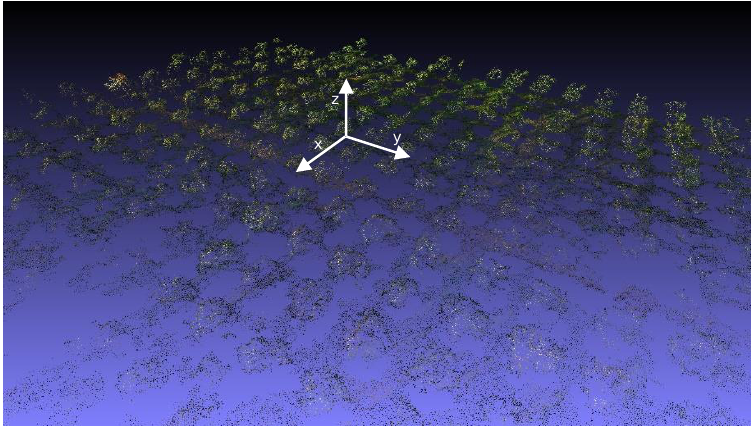
Figure 9. 3D point cloud for the site in Squinzano.